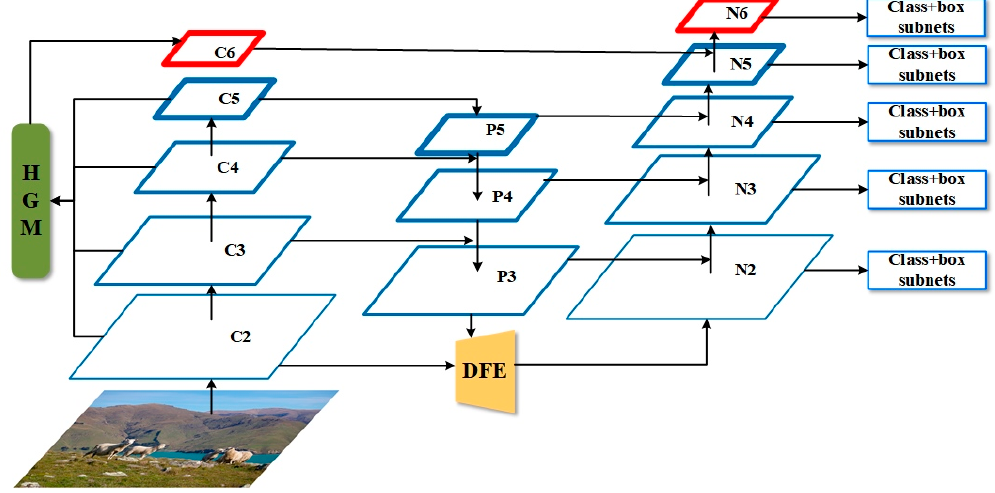
Figure 1. The overall architecture of our proposed model